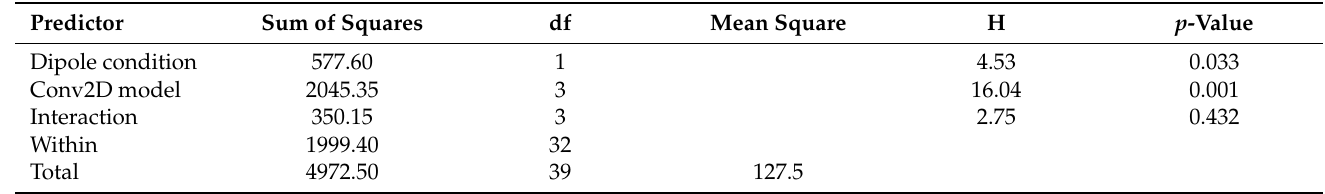
Table A1. Scheirer–Ray–Hare Test using Sensitivity as a criterion. Alpha level = 0.05. Significant results shown in bold. Models: Conv2D, TS = 2, kernel size 4 × 2 versus 4 × 4, Conv2D, TS = 3, kernel size 4 × 3 versus 4 × 4, with TS denoting the amount of time series. Model ( H (3,32) = 16.04, p = 0.001) and dipole condition ( H (1,32) = 4.53, p = 0.03) have significant effects on Sensitivity. Post hoc Mann–Whitney U tests (Bonferroni-corrected alpha level = 0.008) revealed that Sensitivity was significantly higher for Conv2D, TS = 2 ( Mdn = 0.67, 0.67), versus Conv2D, TS = 3 ( Mdn = 0.00,